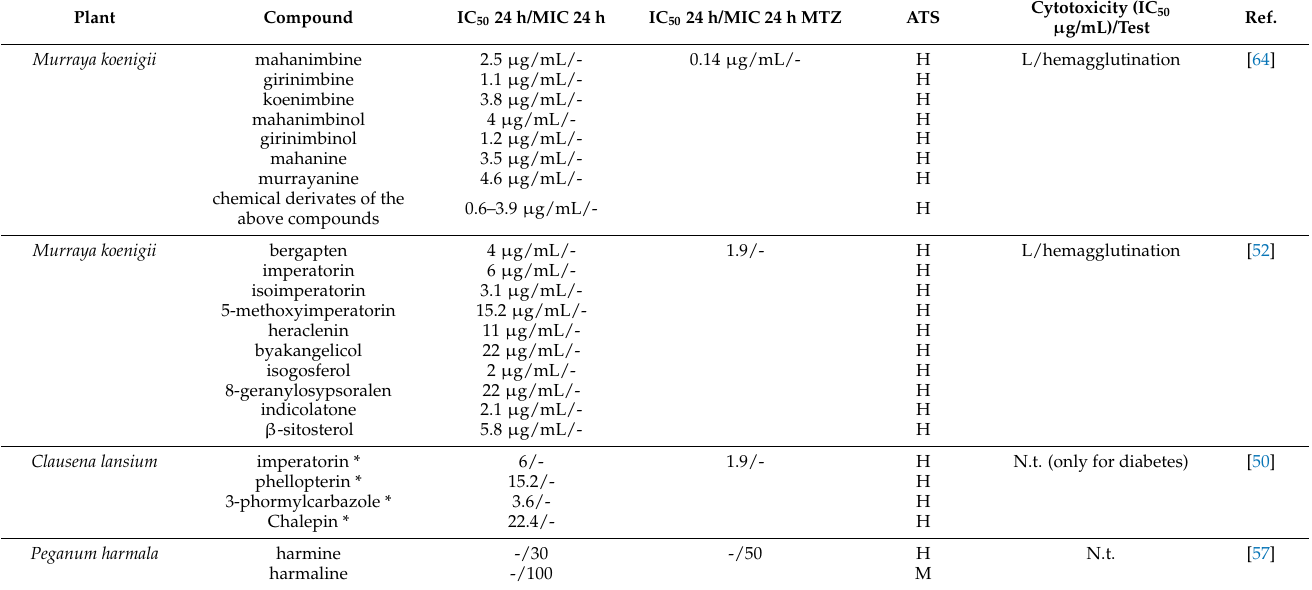
Table 6. Pure compounds employed as anti-trichomonal in vivo. ATS: Anti-trichomonal strength is expressed according to MIC or IC 50